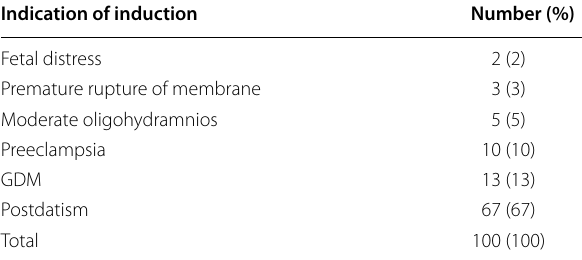
Table 2 Indication for induction of labour